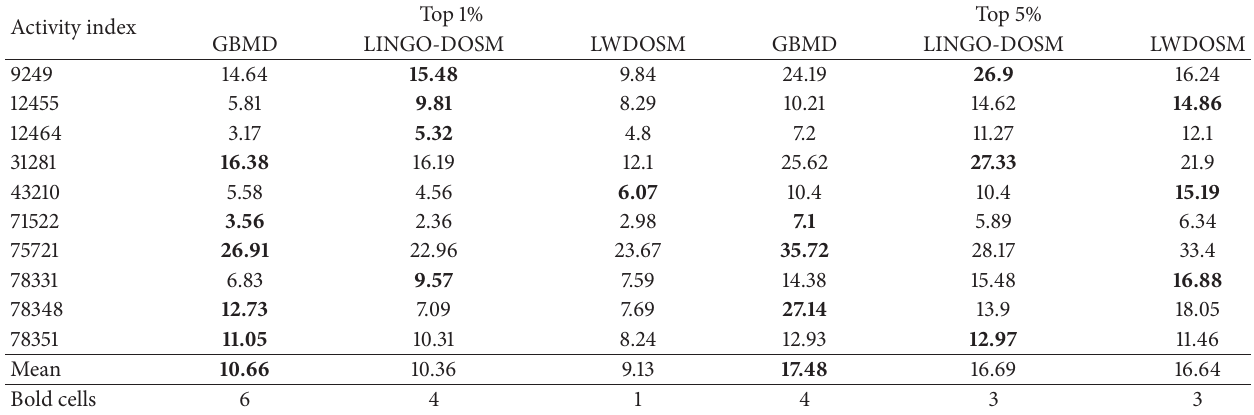
Table 14: Retrieval results of top 1% and 5% for data set DS3 compared with LWDOSM and Lingo-DOSM. Activity